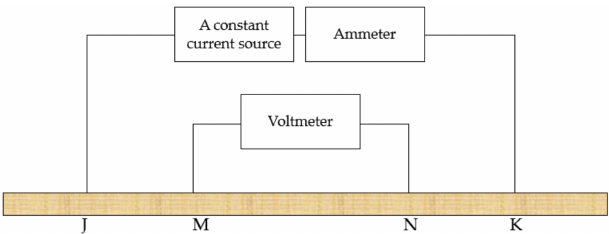
Figure 3. Improved current-voltage four-terminal method schematic